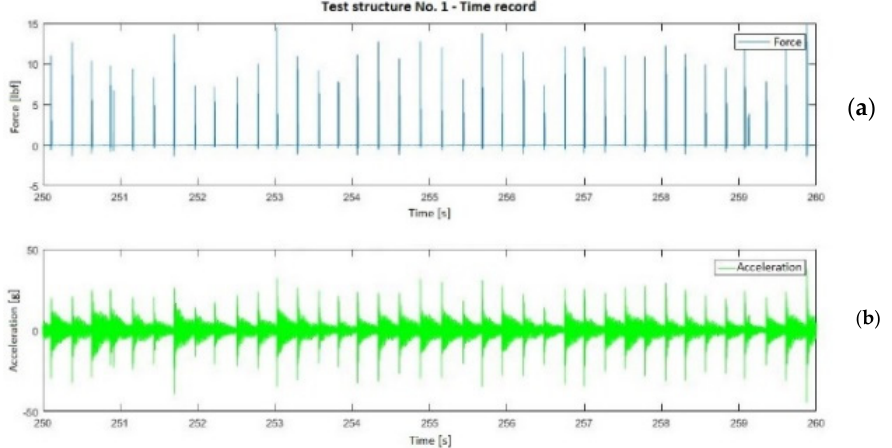
Figure 6. Force and vibration signals in the time-domain: ( a ) the impedance hammer’s force; ( b ) vibration response.